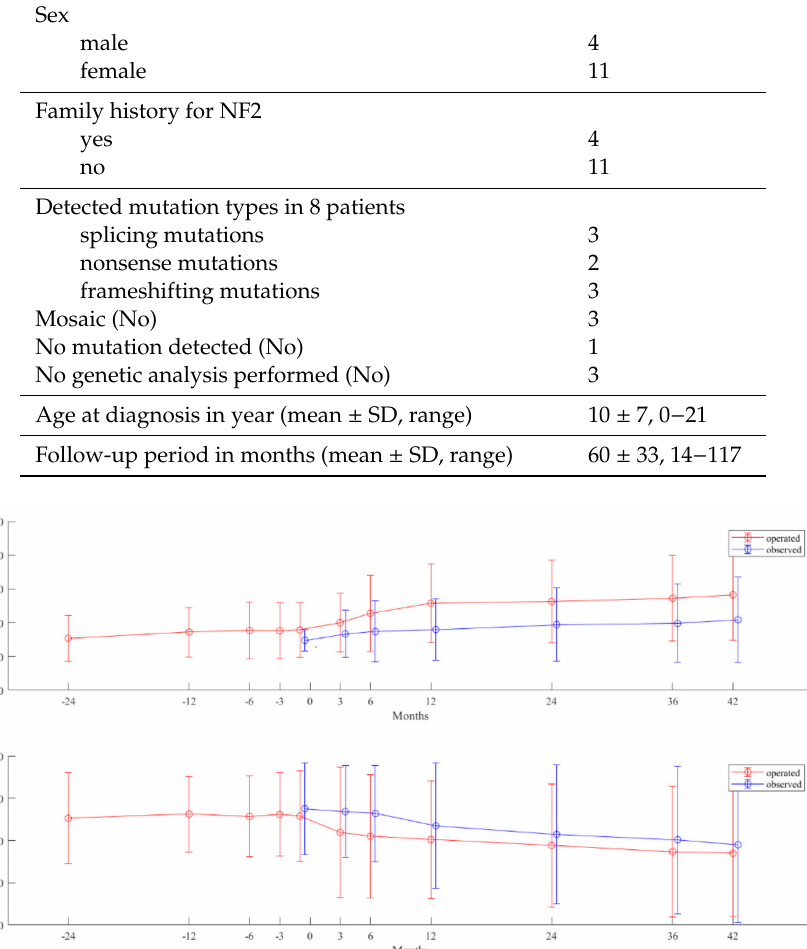
Figure 1. Time course of hearing deterioration in the 39 operated ( red line ) and the 20 non-operated ( blue line ) vestibular schwannoma (VS) in NF2 patients. Pure-tone average ( upper figure ) and speech discrimination score ( lower figure ). Values are in mean ( points ) and standard deviation ( bars ) of tumors in each group at each measuring time point. Time point 0—time point of surgery and starting point of observation in the non-operated (observed)